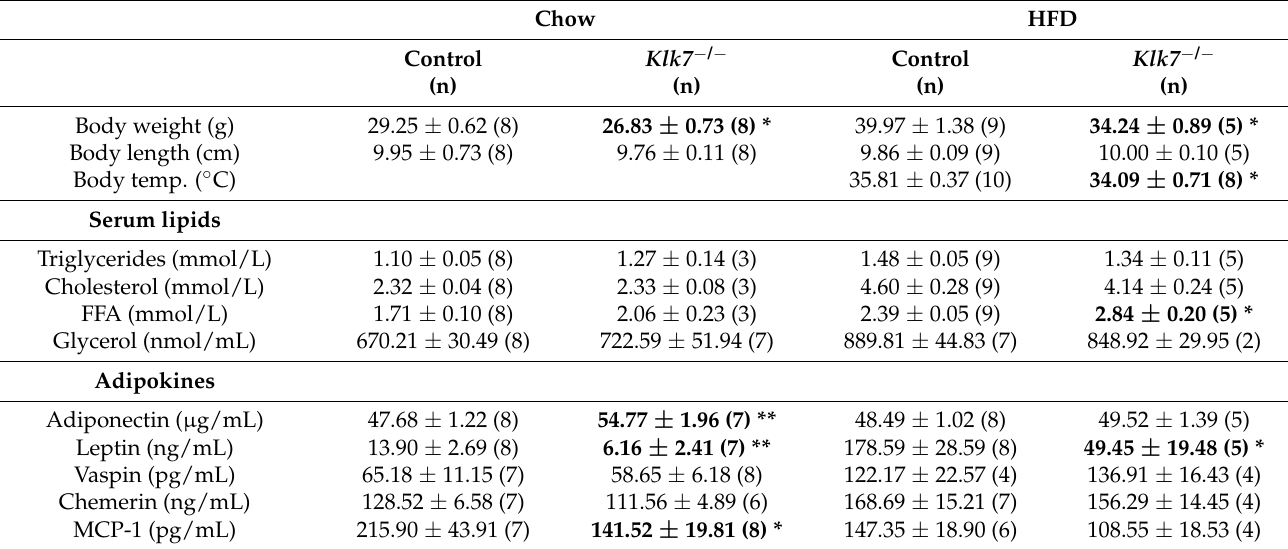
Table 1. Anthropometric and metabolic parameters in male chow and HFD-fed Klk7 − / − and control mice. Chow